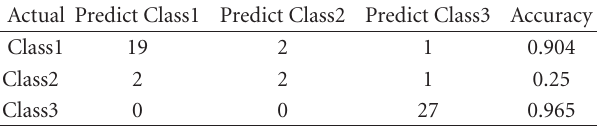
Table 8: Predict performance—confusion matrix.